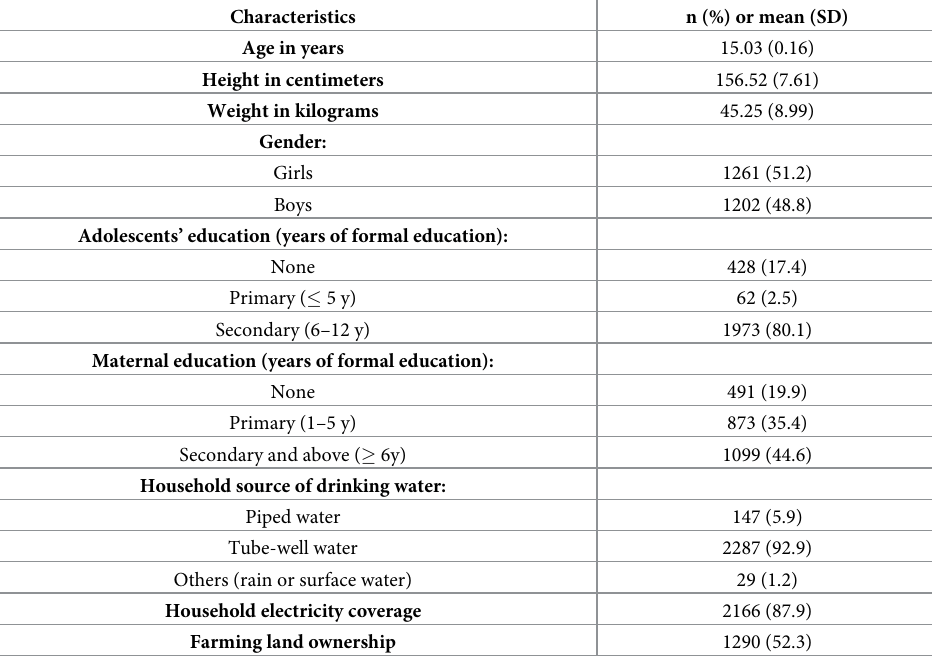
Table 1. Socio-demographic, household and basic anthropometric characteristics of the adolescents in analytic sample (N =